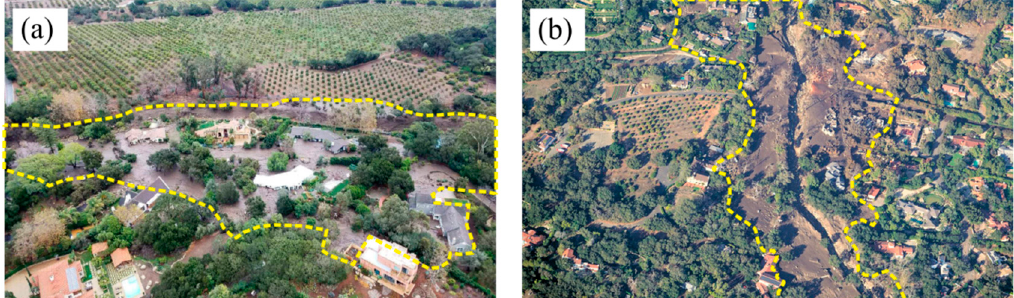
Figure 1. Disaster photos in which the areas affected by the debris flows are circled with yellow lines. ( a ) Homes and streets of a neighborhood affected by the Santa Barbara County mudslides in Santa Barbara, California on 9 January 2018, from the perspective of a Coast Guard MH-65 Dolphin helicopter crew involved in rescuing injured and stranded victims. (Modified from U.S. Coast Guard photo [30]); ( b ) San Ysidro Ranch and Casa de Maria damage taken on 11 January 2018 due to the catastrophic debris flow from heavy rains after the Thomas Fire, modified from [31].